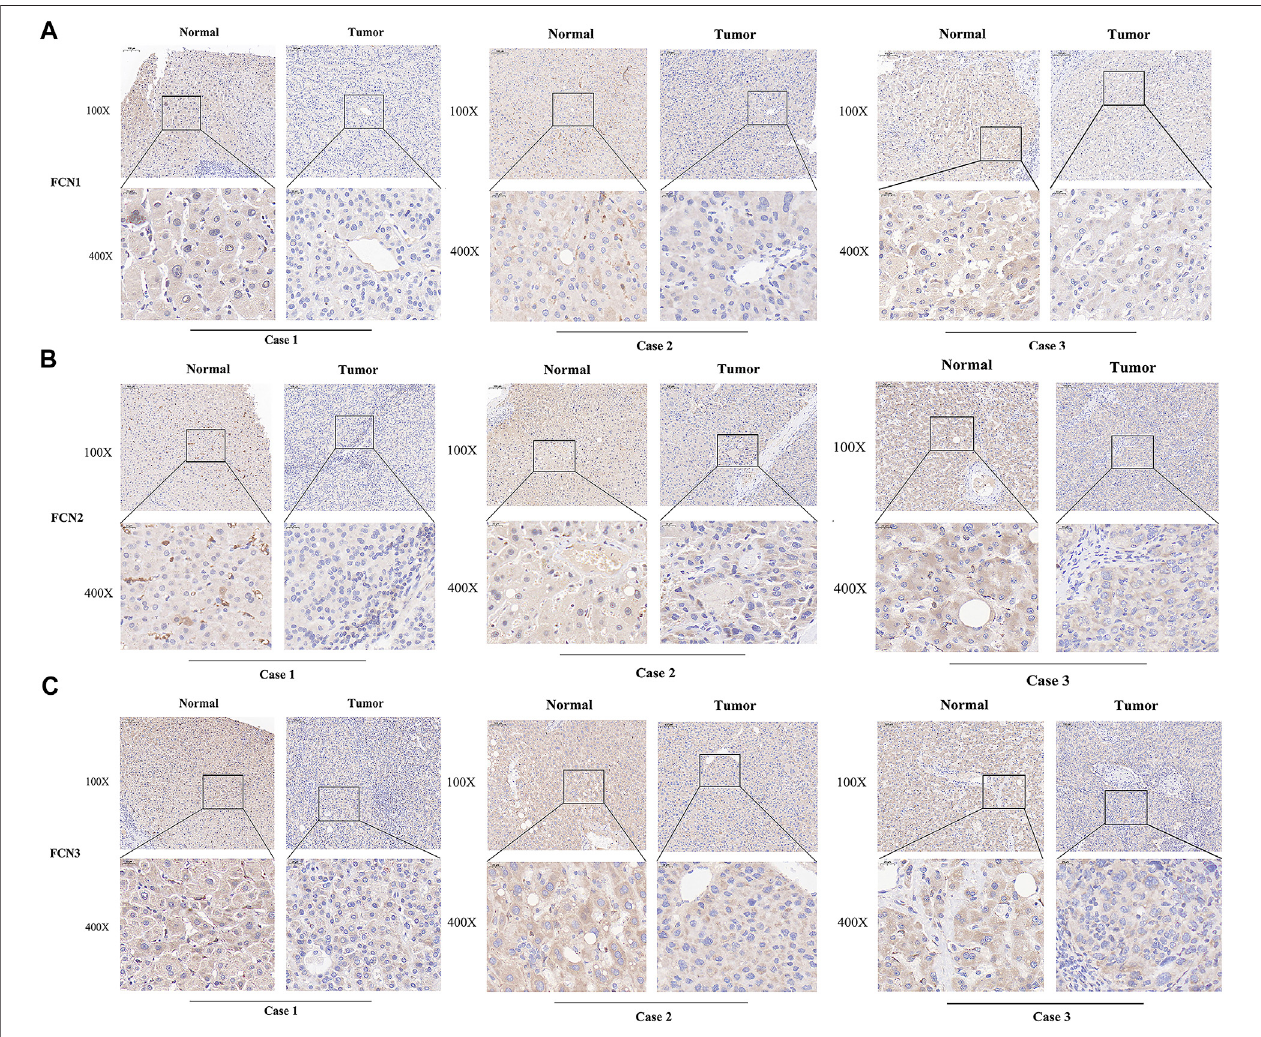
FIGURE 2 | Immunohistochemistry of FCNs in three pairs of HCC tissues. (A) FCN1; (B) FCN2; (C) FCN3.